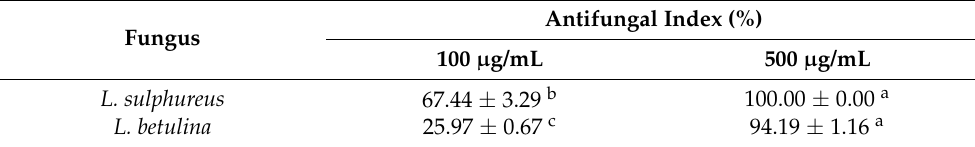
Table 1. Antifungal index of M. formosana leaf essential oil against wood-rotting fungi. Fungus